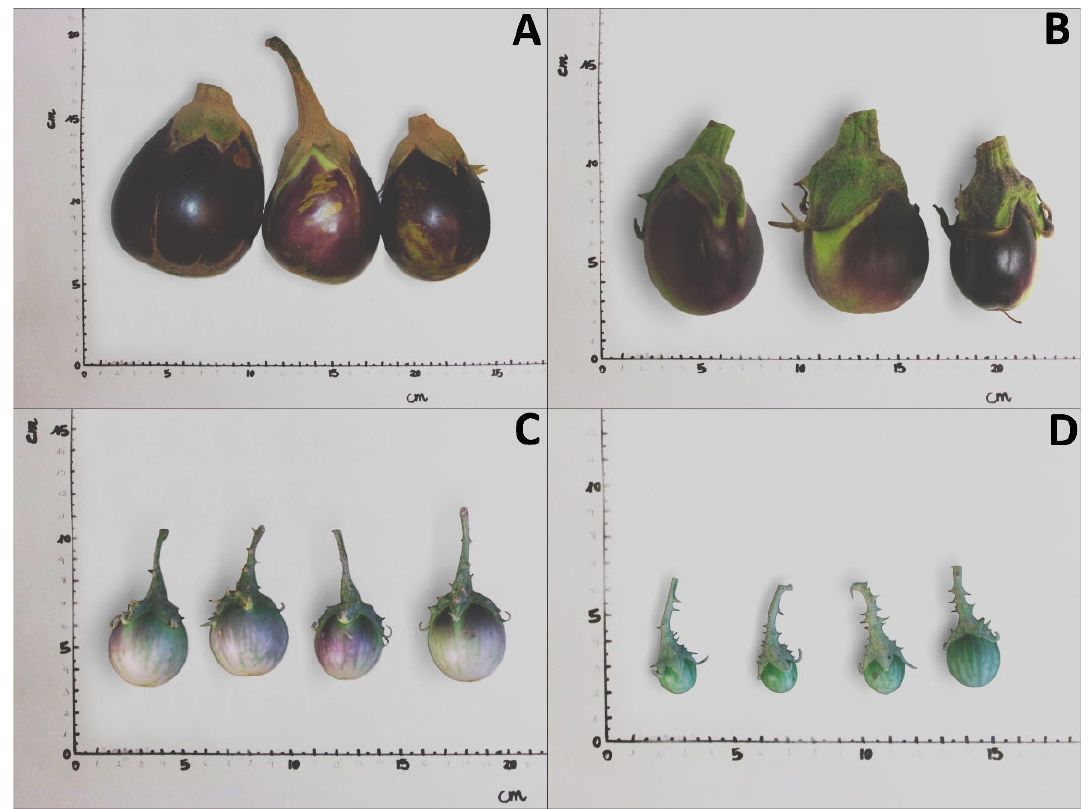
Figure 1. Representative fruits of the parents of the IL population and the hybrid: ( A ) fruits of the recipient parent AN ‐ S ‐ 26 ( S. melongena ) harvested under open field; ( B ) fruits of AN ‐ S ‐ 26 under screenhouse; ( C ) fruits of the F 1 hybrid under open field; ( D ) fruits of the donor parent MM577 ( S. incanum ) under an open field. The scale is in cm.